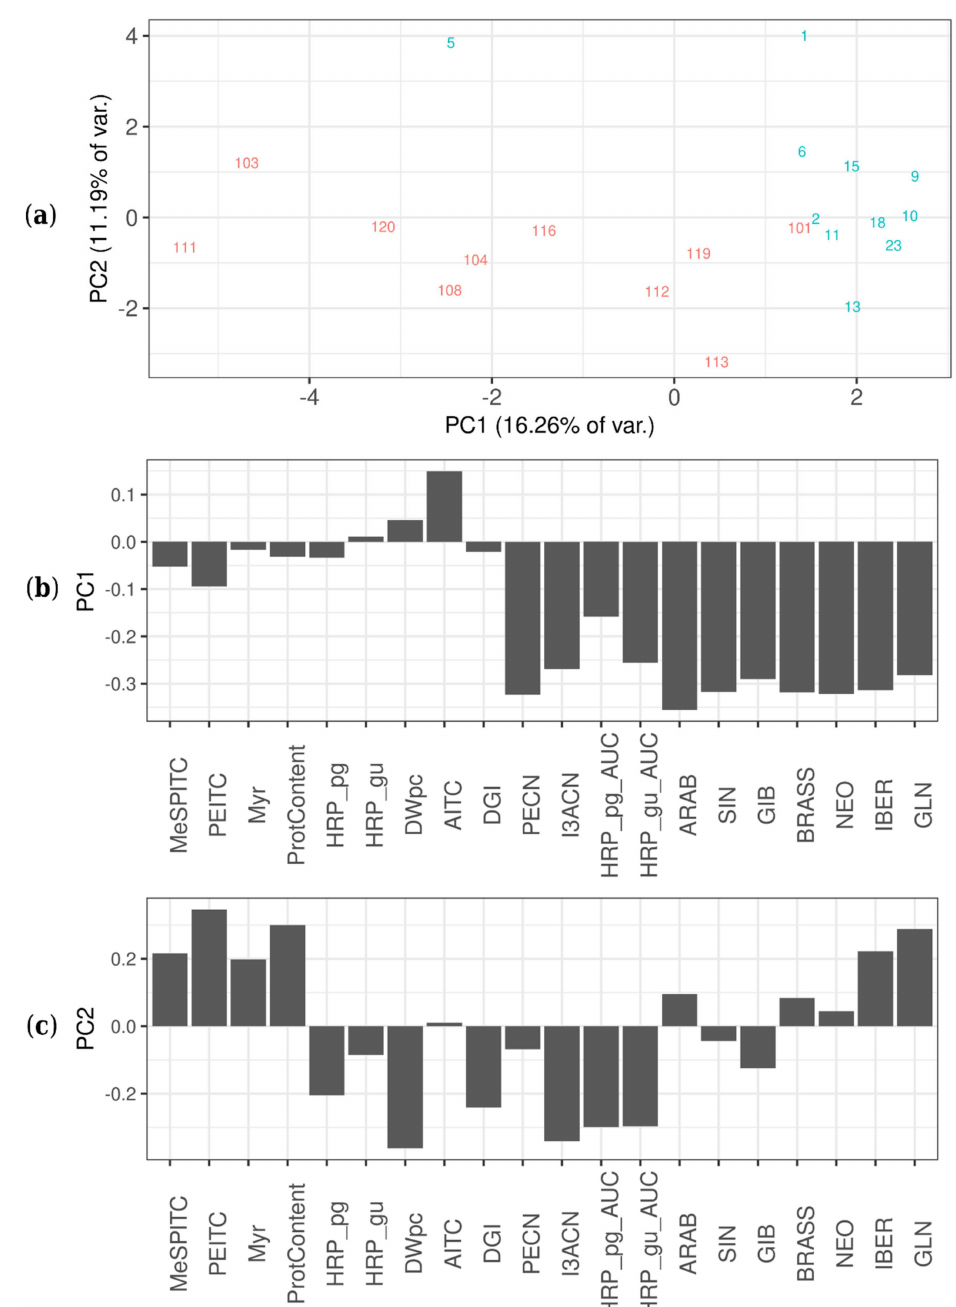
Figure 3. Principal component analysis score plot of all variables of the tested di ff erent horseradish ( Armoracia rusticana ) hairy root clones, including glucosinolate content, isothiocyanate content as well as enzyme activities / patterns. ( a ) Principal component analysis score plots showing di ff erent hairy root clones (HRCs) in the PC1—PC2 plane, separated by their features. The lines of di ff erent origins are shown with di ff erent colors: red—petiole, blue—leaf blade. ( b ) Contribution of features (loading values) to score values of horseradish hairy root cultures, in principle component 1 (PC1). Feature abbreviations: HRP_pg—horseradish peroxidase activity with pyrogallol as substrate (mmol pyrogallol min − 1 mg − 1 protein); HRP_gu—horseradish peroxidase activity with guaiacol as substrate (mmol guaiacol min − 1 mg − 1 protein); Myr—myrosinase activity; ProtContent—protein content (mg protein mg − 1 fresh weight); MeSPITC—3-(methylthio)propyl isothiocyanate (abundance); PEITC—2-phenylethyl